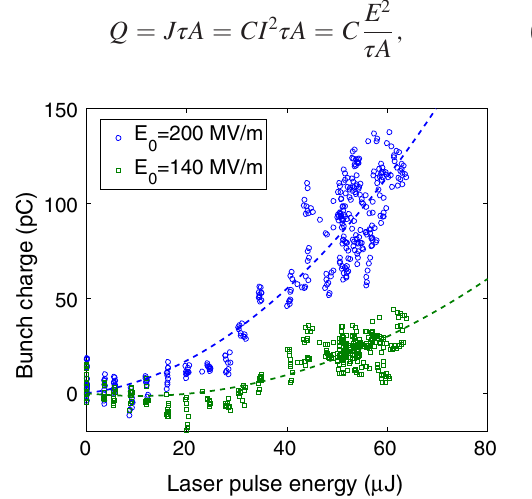
FIG. 4. Absorbed laser pulse energy E(1-R) vs electron bunch charge. The dashed lines are quadratic fits of the data. The E 0 is the peak field, and the gun operates at 50 degrees from zero crossing. The reason for large scatter of data points is the same as in Fig.